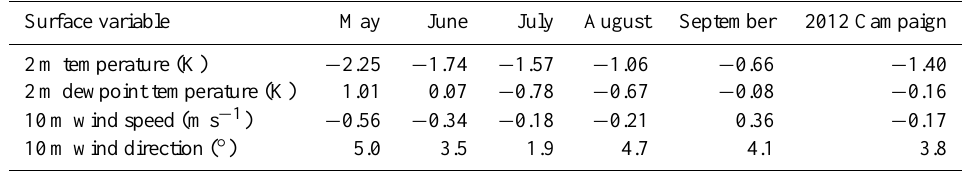
Table 2. 2012 WRF v3.4.1 model biases for selected surface variables. Wind speed and direction errors are computed using observations ≥ 3kn ( ∼ 1.5ms − 1 ) . Positive direction is clockwise.